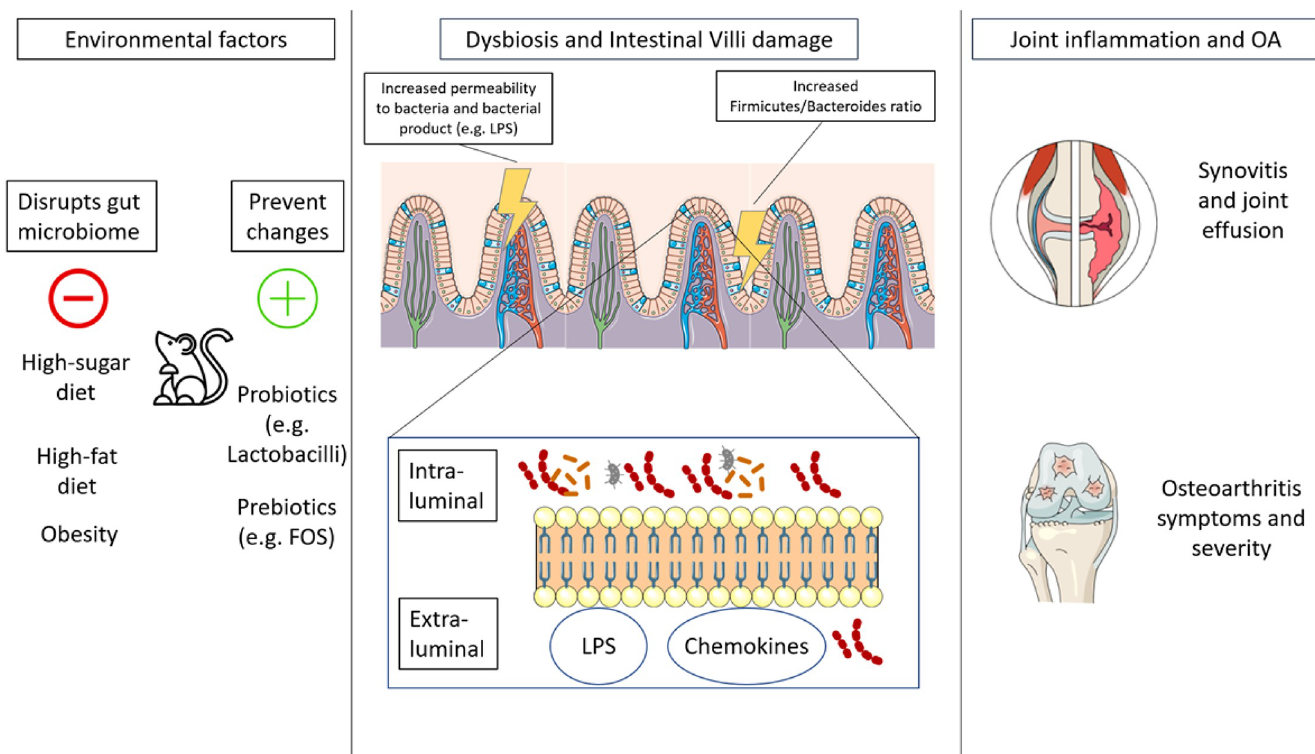
Fig 2. The model of gut-joint axis. FOS: fructooligosaccharides; LPS: lipopolysaccharide; OA: osteoarthritis. In the picture are described the three main actors of the gut-joint axis in OA development. Environmental factors act as either stressor or protectants of gut integrity and microbiota health. If this balance is disrupted, bacterial metabolites and byproducts such as LPS and chemokines pass the gut barrier into the blood flow causing distant damage to diarthrodial joints such as the knee. In the long-term, similar damage together with immune priming can initiative OA changes and affect pain and functionality.